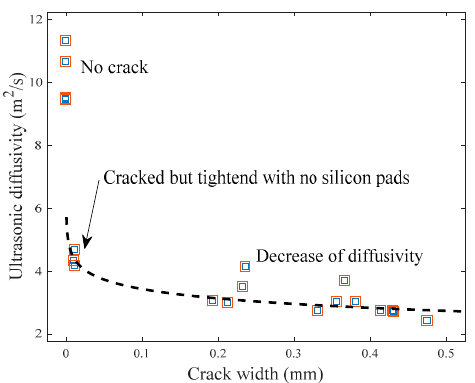
Figure 11. Relationship between ultrasonic diffusivity and average crack width.